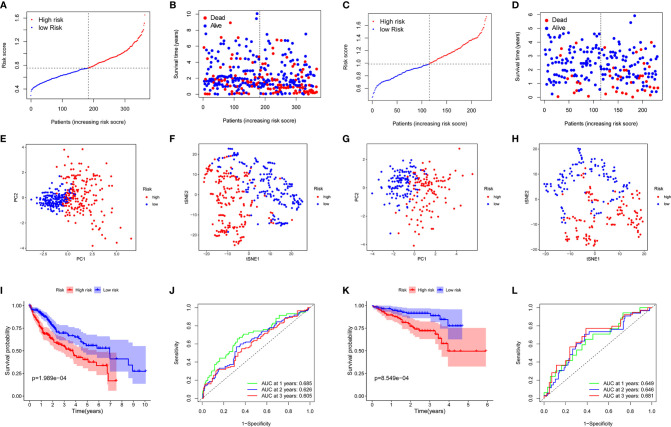
Prognostic analysis of the 8-gene signature model in the TCGA cohort and ICGC cohort. TCGA cohort (A, B, E, F, I, J), ICGC cohort (C, D, G, H, K, L). (A, C) The median value and distribution of the risk scores. (B, D) The distribution of OS status. (E, G) PCA plot. (F, H) t-SNE analysis. (I, K) Kaplan-Meier curves for OS of patients in the high- and low-risk groups. (J, L) AUC time-dependent ROC curves for OS.